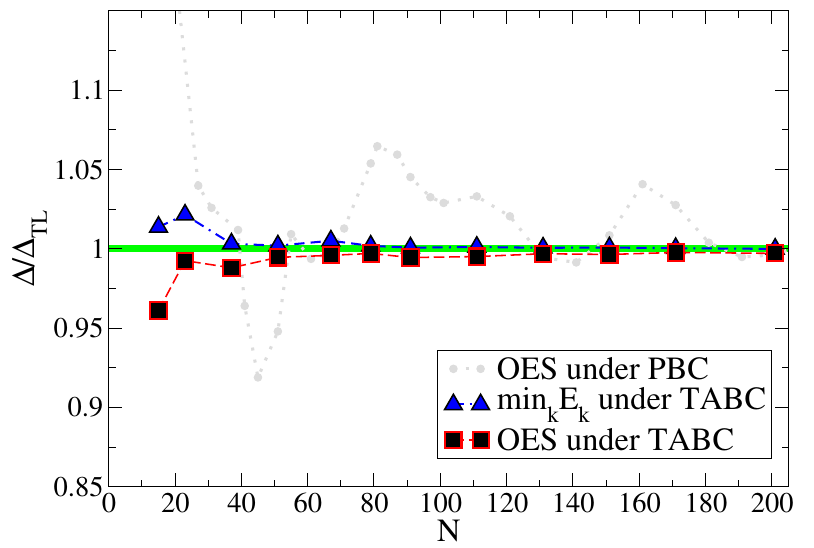
Figure 9. The twist-averaged OES for k F a = − 10. The twist-averaged minimum of the quasiparticle excitation energy from Figure 3 is also shown for